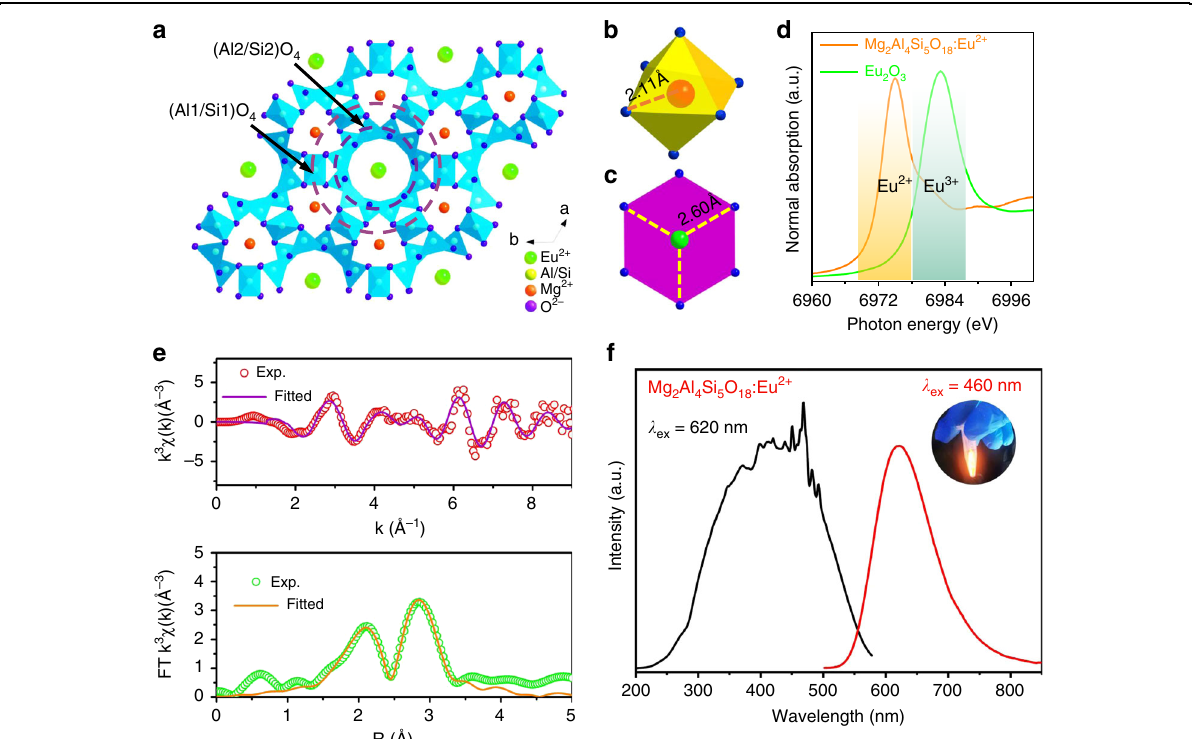
Fig. 3 Crystal structure, local structure analysis and optical properties of the Mg 2 Al 4 Si 5 O 18 :Eu 2 + composite phosphor. a 2×2×2 type super- cell of hexagonal Mg 2 Al 4 Si 5 O 18 :Eu 2 + crystal structure viewing along c -axis. The local coordination of b MgO 6 and c EuO 6 polyhedron, showing the Mg – O and Eu – O bond lengths. d X-ray absorption near-edge structure (XANES) spectra of the Eu L 3 edge in Mg 2 Al 4 Si 5 O 18 :Eu 2 + and Eu 2 O 3 . e k 3 - weighted Eu L 3 edge EXAFS spectra and the corresponding Fourier transform of the Mg 2 Al 4 Si 5 O 18 :Eu 2 + composite fi tting as a function of R. f Room temperature PLE and PL spectra of Mg 2 Al 4 Si 5 O 18 :Eu 2 + composite, the sharp lines around 450 nm in PLE spectra are caused by xenon lamp light scattering and the spectra is uncorrected. The inset shows the powder under 365 nm light UV